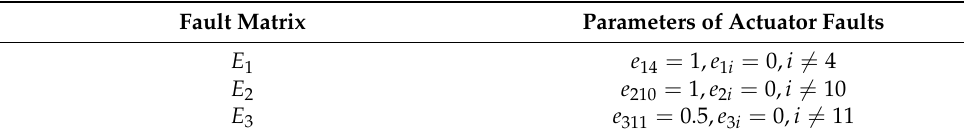
Table 4. The parameters of actuator faults.